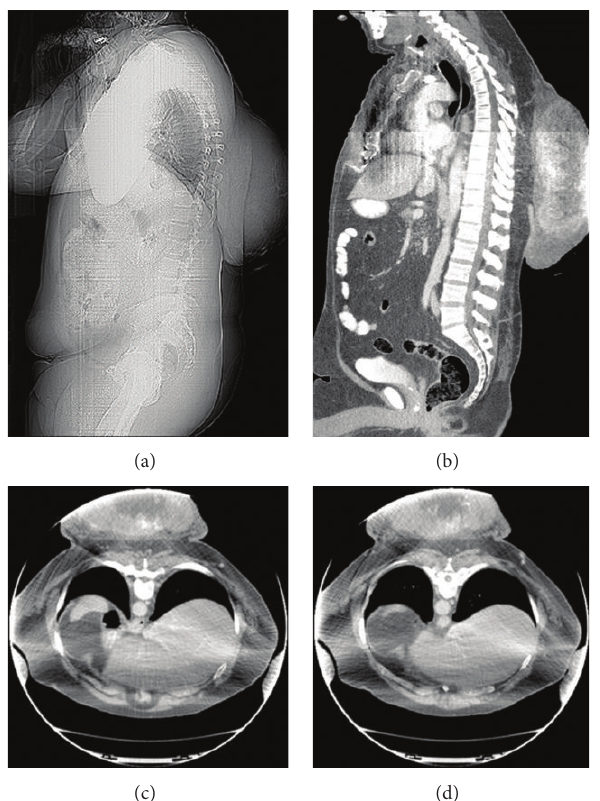
Figure 1: The scoutogram (a) reveals a very large bulky mass within the posterior midback. Sagittal (b) and axial contrast enhanced CT images ((c) and (d)) show a large heterogeneous mass which is not completely imaged and partially extrinsically compressed in the gantry. The mass demonstrates central area of hypodensity consistent with necrosis as well as scattered, coarse calcifications. This mass is in close proximity to the superficial skin and subcutaneous tissue without much involvement of deep structures.